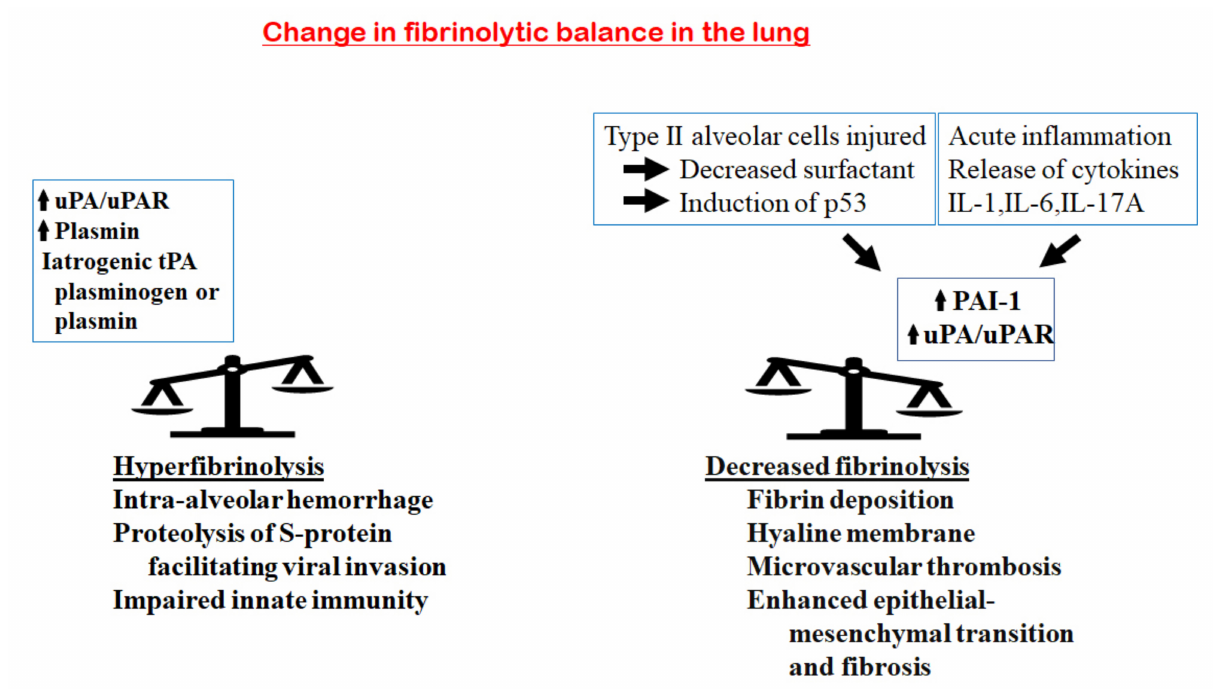
Figure 4. Changes in the fibrinolytic balance in the lung in COVID-19. On the one hand, an increase in fibrinolytic components, including uPA/UPAR, plasmin, iatrogenic tPA, plasminogen or plasmin, would tilt the balance towards hyperfibrinolysis. This enhances the proteolysis of the viral S-protein and facilitates viral invasion; increases the breakdown of fibrin in the alveoli, generating more D-dimer; enhances the risk of intra-alveolar hemorrhage and impairs the innate immunity of host cells. On the other hand, the acute inflammatory response in the lung releases inflammatory cytokines (IL-1, IL-6 and IL-17A), leading to an increase in PAI-1 and a decrease in the uPA/uPAR complexes. In addition, injury of the type II alveolar cells results in decreased surfactant and the induction of the p53 pathway that upregulates PAI-1. These will tilt the balance to hypofibrinolysis, with the consequences of increased fibrin deposition, hyaline membrane formation, microvascular thrombosis, enhanced epithelial–mesenchymal transition and